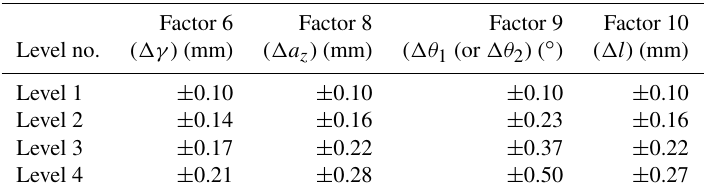
Table 8. Tolerance factor levels re-division for U 20 (4 4 ) array within tolerance zones (part A). Factor 6